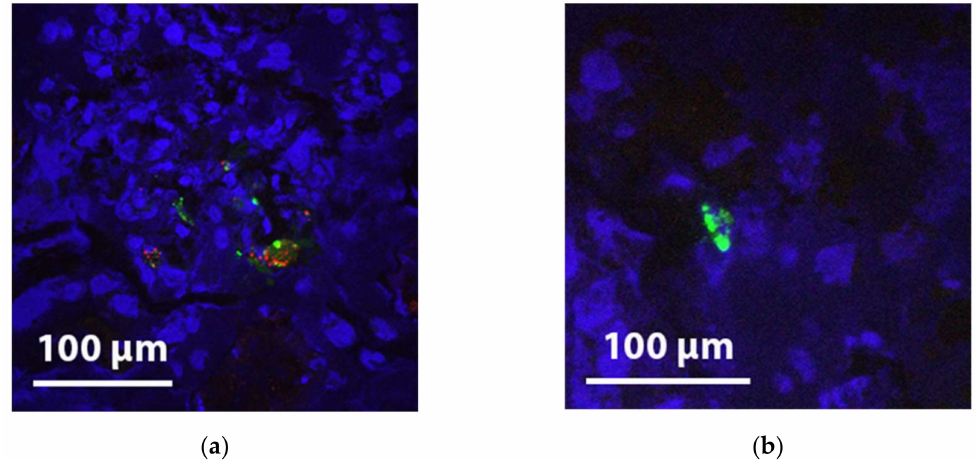
Figure 3. ( a ) Glomerular PKH (green) and Qtracker-625 (red), DAPI (blue) fluorescence in cortical tissue after NMP with 10 7 MSCs added indicating intact MSCs; ( b ) fluorescent hot spot in the glomeruli, which solely has positive PKH staining and no Q-tracker signal. Such findings could indicate disintegrated